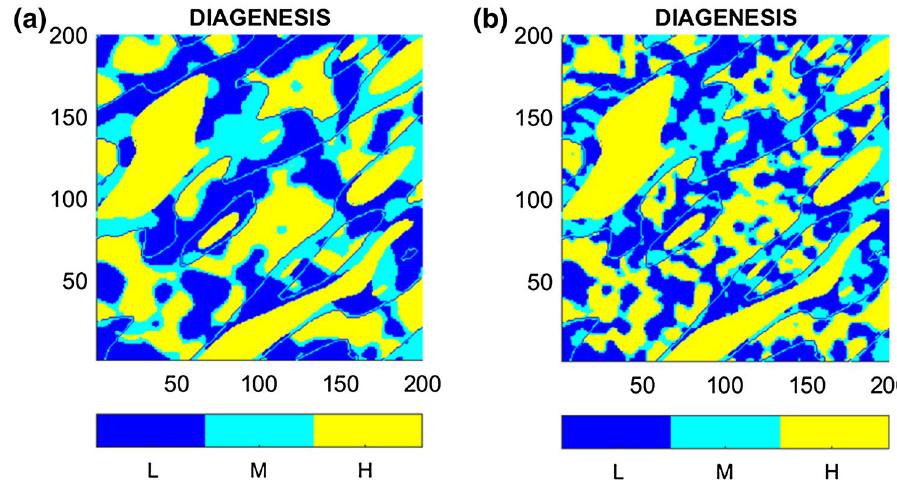
Fig. 8 a Diagenetic model DM1 with a variogram range of 20 m. b Diagenetic model DM2 with a variogram range of 10 m. The lines overimposed on the figures indicate the boundaries of the